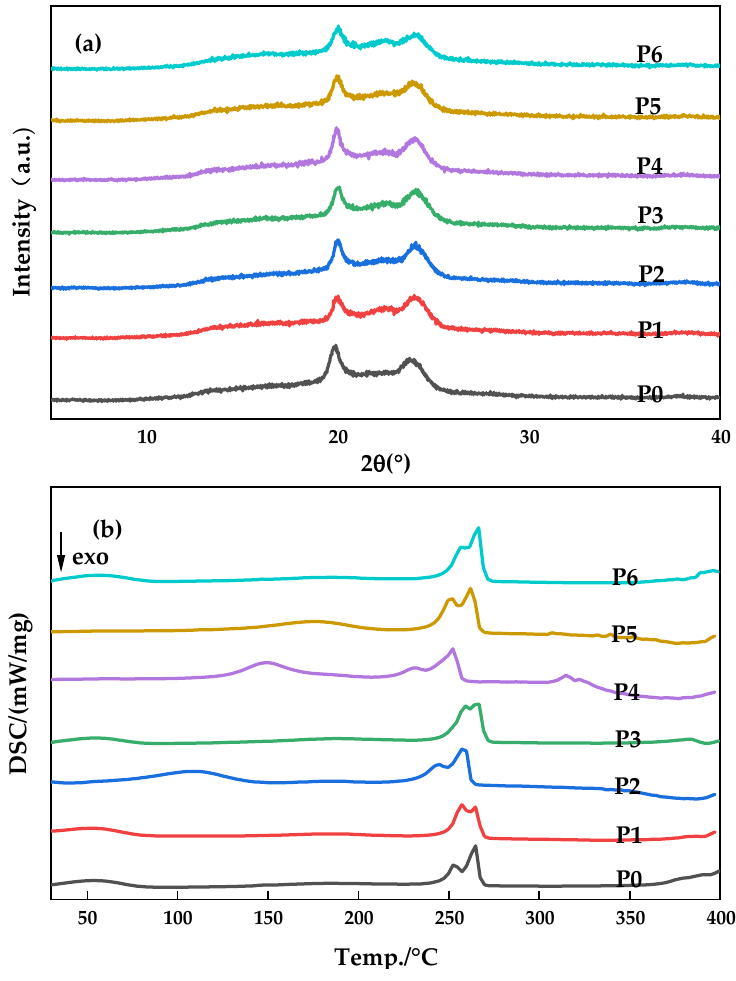
Figure 5. X-ray diffraction patterns ( a ) and DSC curves ( b ) of various PA66 membranes.